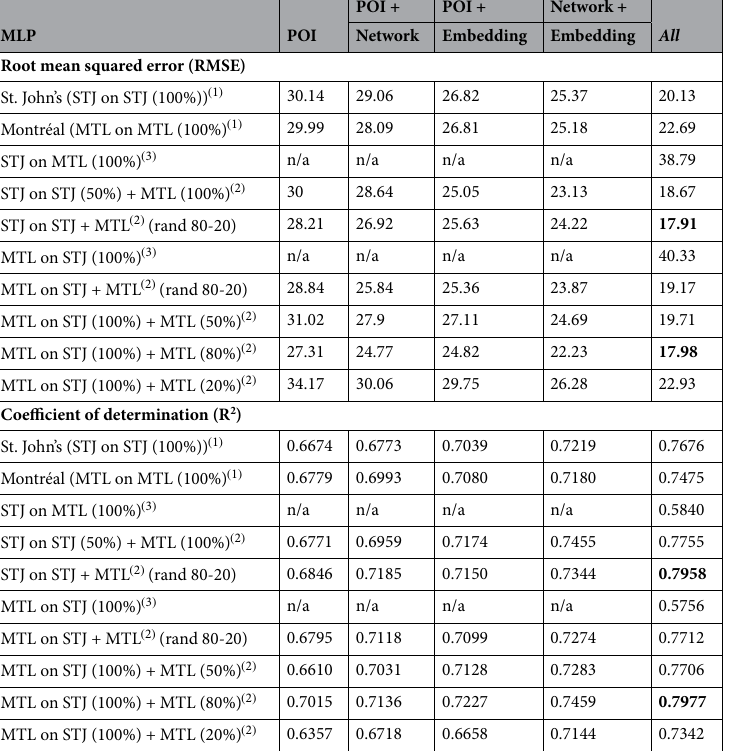
Table 5. Exploration of the three experimentation approaches (1) matching, (2) combined and (3) zero-user- input over 5 different feature combinations and 2 different data split approaches based on data from the cities of St. John’s NL and Montréal QC. Reflecting RMSE error range of 0–100 units and R 2 . Significant values are in